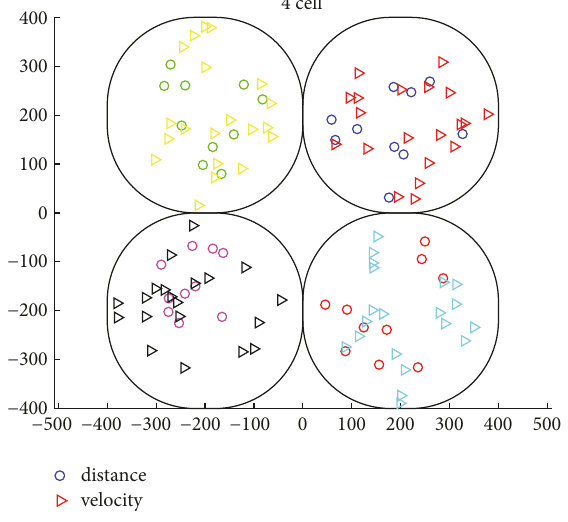
measurements. This angular spread has now been defined in terms of 𝜎 which is the width of the GMF. When 𝜎 = 0 , the Gaussian Fuzzy Circle reduces to the conventional crisp circle. The centre of the fuzzy circle is also fuzzy and the radius is a linear combination of fuzzy